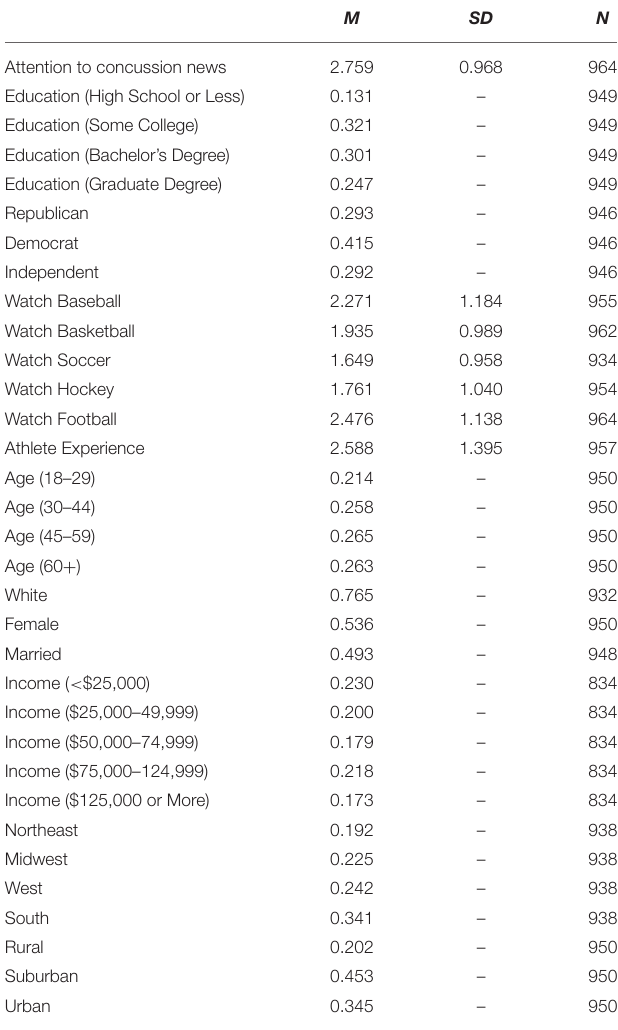
TABLE 1 | Descriptive statistics for all study variables